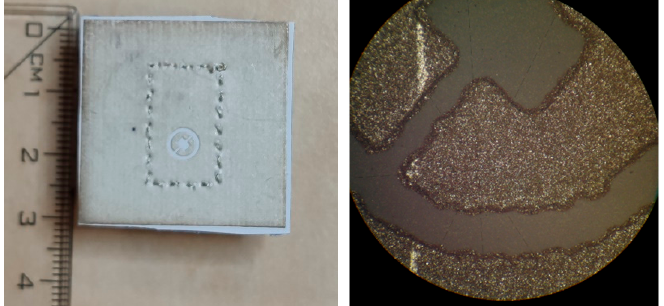
Figure 9. Photograph of the screen-printed antenna ( left ); microscopic view of the slot ( right ). Similarly, the axial ratio (AR) is shifted for the screen-printed antenna; the textile- integrated copper antenna shows the AR minimum at 24 GHz but the AR value is about 5 dB.